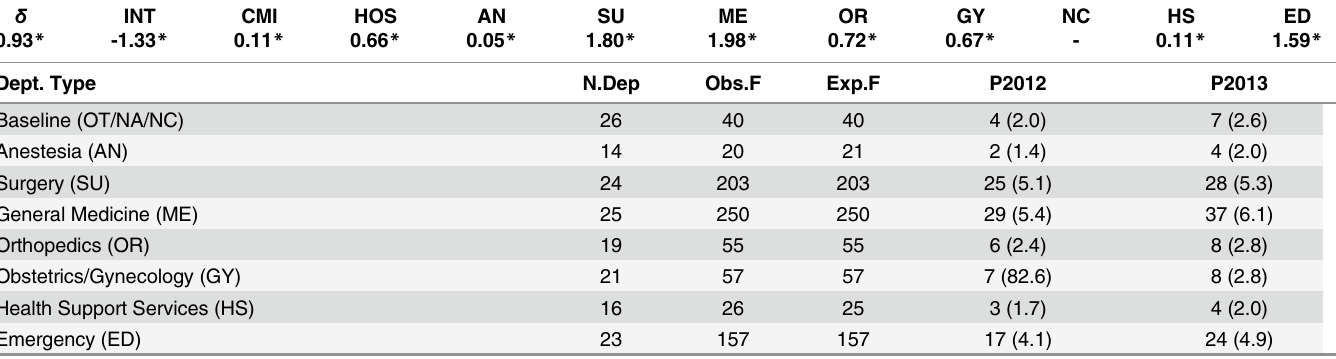
Table 8. Results for deaths, for the Lombardia region. Estimates of the parameters of the Poisson model as per Appendix 2.1, number of departments of a given type that generated each alleged type of claim (N.Dep), observed frequencies of claims for the different types of departments (Obs.F), expected fre- quencies according to the model (Exp.F), and predicted claims for 2012 (P2012) and 2013 (P2013), together with their standard deviations (in brackets).